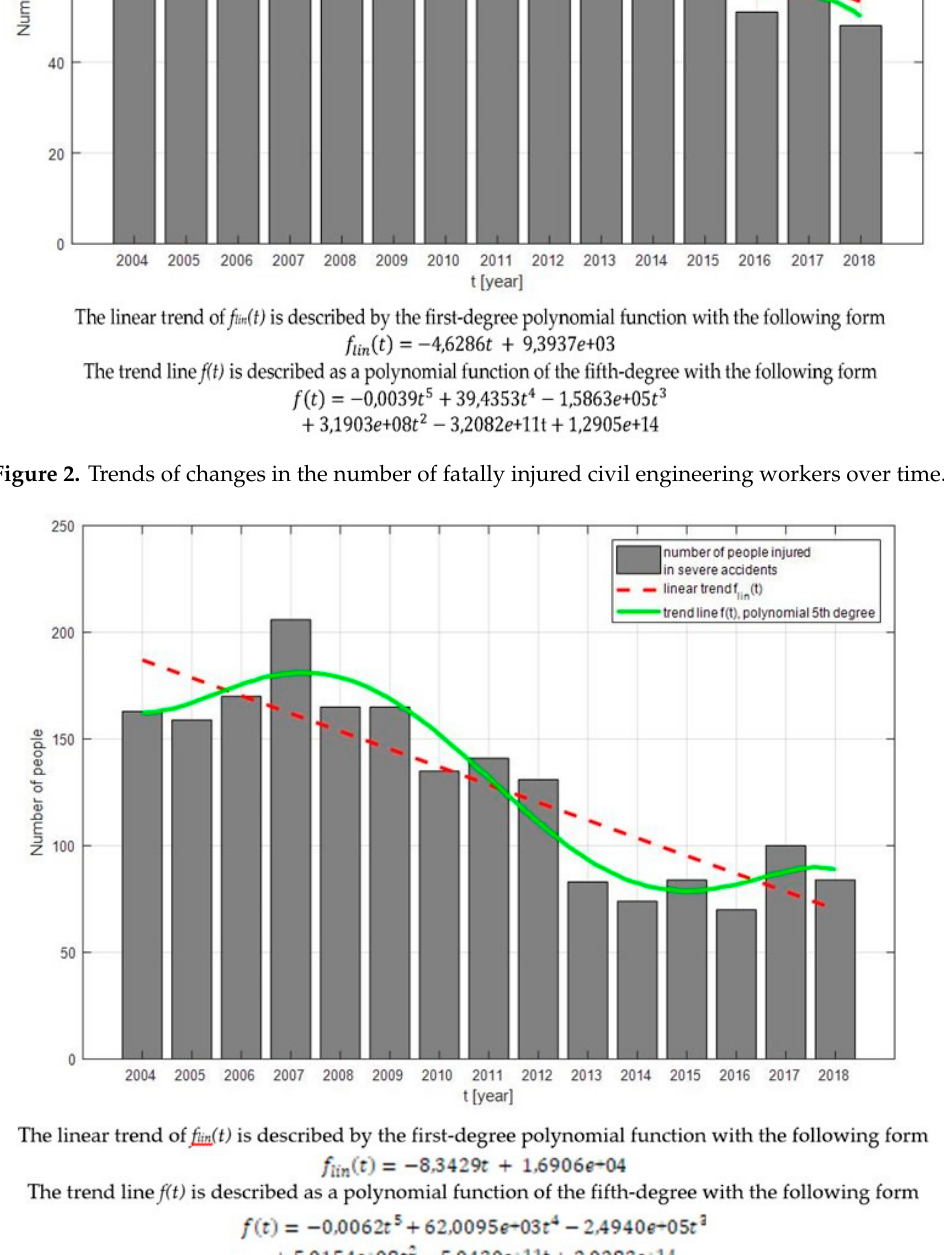
Figure 3. The evolution over time of the number of civil engineering workers injured in severe accidents.